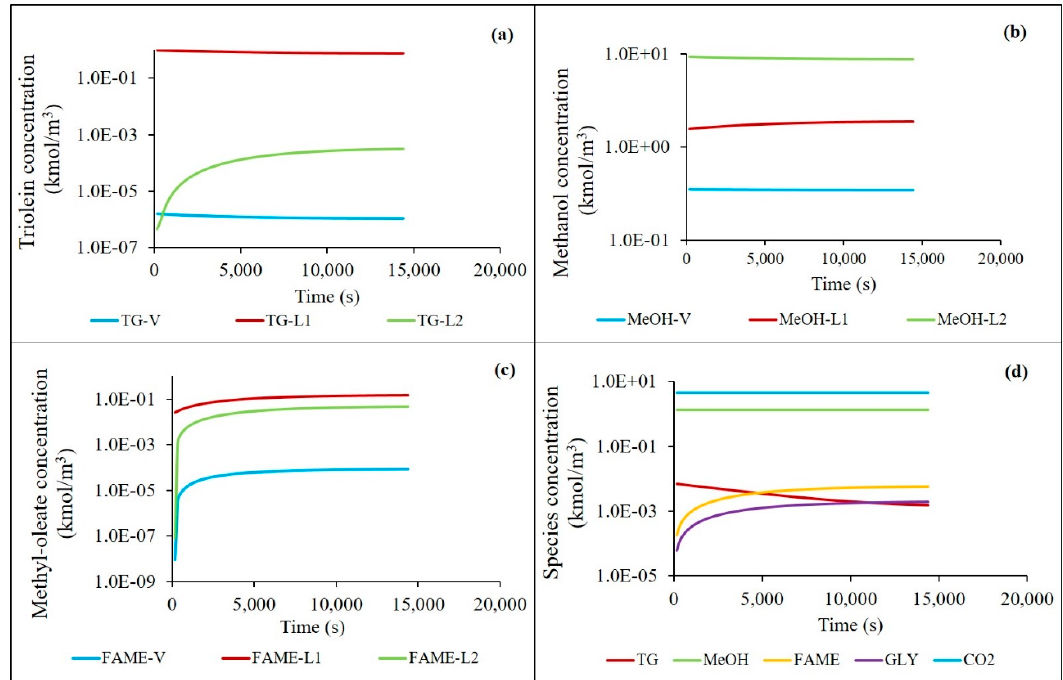
Figure 2. Concentration profiles of ( a ) Triolein, ( b ) Methanol, ( c ) FAME, and ( d ) All species, for 550X MeOH/triolein molar ratio at 9.65 MPa and 95 °C. V-Vapor, L1-Liquid 1, L2-Liquid 2 phase.